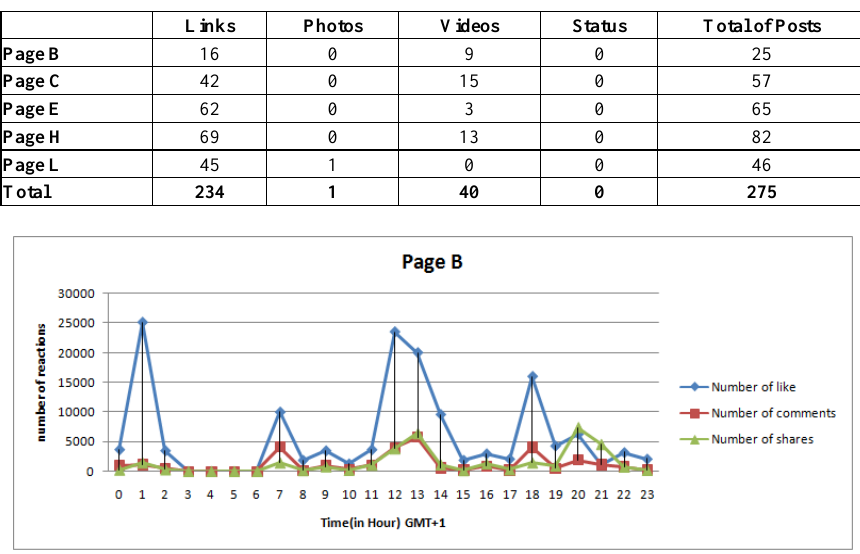
Table 4. Number of posts by type of each page